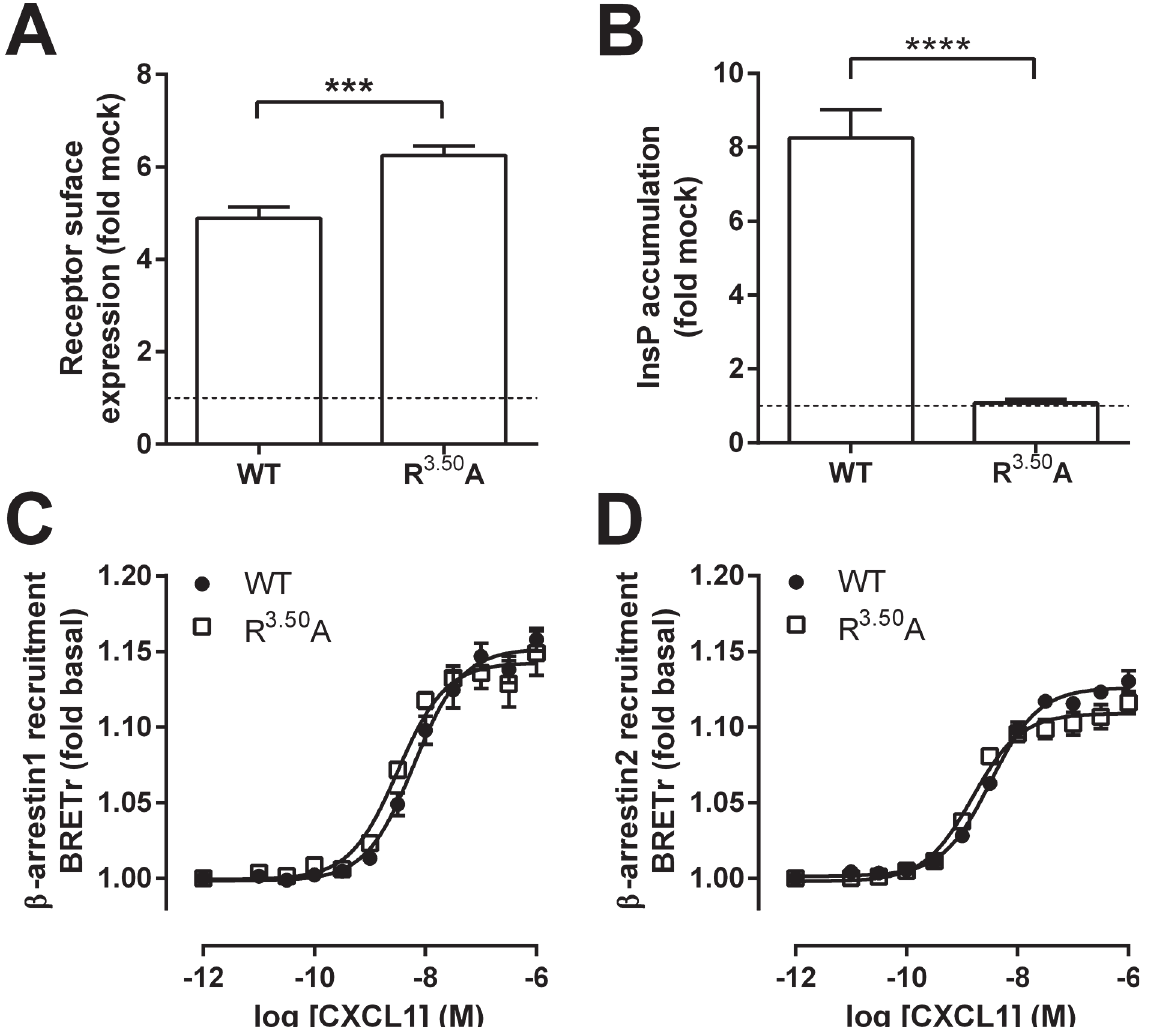
Fig 3. Characterization and β -arrestin recruitment to ORF74-R 3.50 A. (A, B) HEK293T cells were transiently transfected with WT-ORF74 (WT), ORF74-R 3.50 A (R 3.50 A) or empty vector DNA (mock-transfected). Relative receptor expression at the cell surface was determined by ELISA (A) and constitutive activation of PLC was determined by measuring InsP accumulation (B). Data are presented as fold over mock-transfected cells (dotted line). (C, D) HEK293T cells expressing ORF74-Rluc8 (WT) (filled circles) or ORF74-R 3.50 A-Rluc8 (R 3.50 A) (open squares) in combination with β -arrestin1-eYFP (C) or β -arrestin2-eYFP (D) were stimulated with increasing concentrations of CXCL1. Data are shown as fold over basal. All data are represented as the mean of pooled data from at least three independent experiments each performed in triplicate and error bars indicate SEM values. Statistical differences of cell surface expression (A) or constitutive PLC activation (B) between WT-ORF74 and ORF74-R 3.50 A were determined by a Student t test ( **** p (cid:1) 0.0001, *** p (cid:1) 0.001).